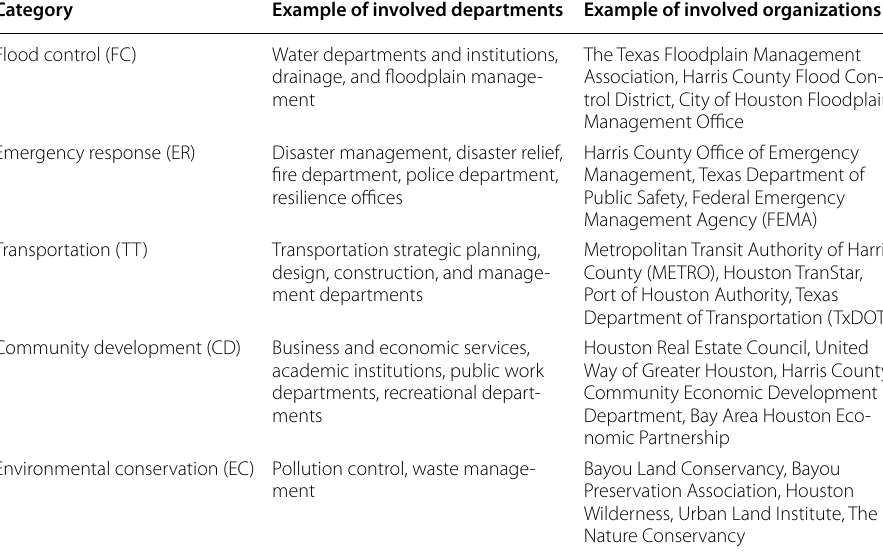
Table 2 Examples of departments and organizations in classified urban sectors Category Example of involved departments Example of involved organizations Flood control